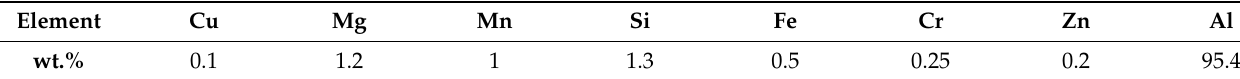
Table 2. Chemical composition of AA6068 aluminum alloy.